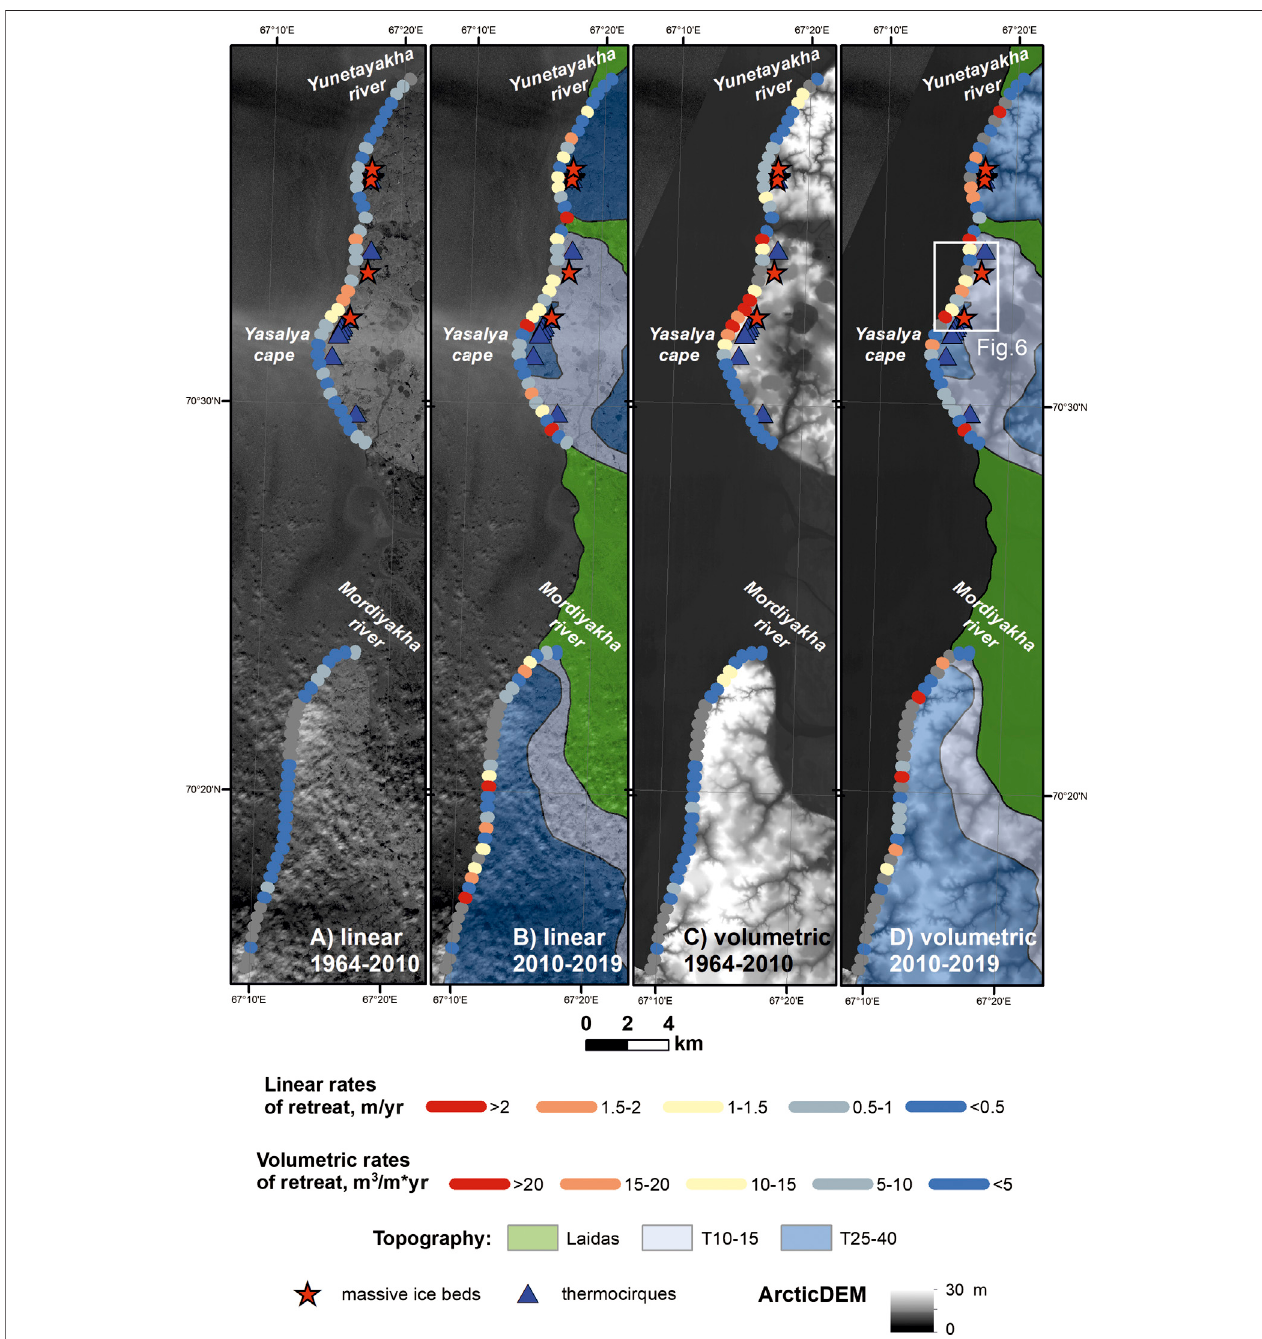
FIGURE 5 | Rates of retreat of the eastern coast of Gulf of Kruzenstern (area 1, Figure 1C ), for 1964 – 2010 and 2010 – 2019. The dots indicate rates of shoreline retreat measured at every 500 m. Gray dots ( “ no data ” ) correspond to areas covered by clouds where it was impossible to calculate retreat rates. “ T10 – 15 ”— coastal plain (terrace) with heights of 10 – 15 m; “ T25 – 40 ”— coastal plain (terrace) with heights of 25 – 40 m. The position of Figure 6 is shown as a white